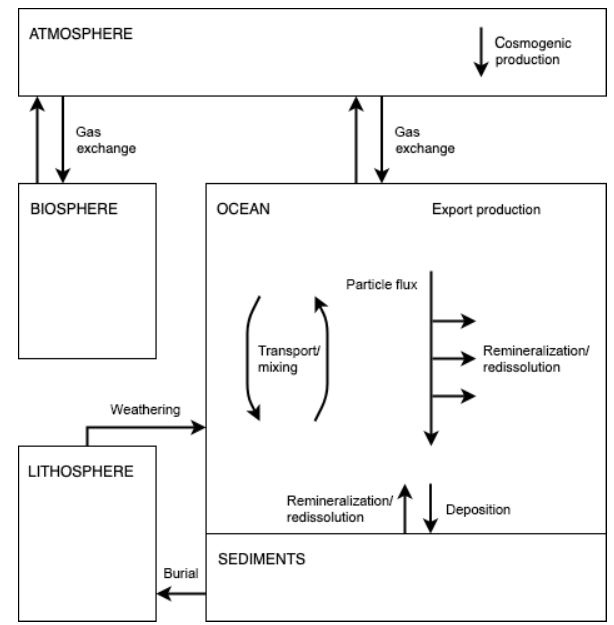
Figure 2. Schematic diagram of the Bern3D carbon cycle model. The fully coupled model includes the major global carbon reservoirs (atmosphere, terrestrial biosphere, ocean, and sediments) and the exchange fluxes between them. Biogeochemical processes, namely air–sea gas exchange, biological export production, and particle flux through the water column, are parameterized by refined OCMIP-2 formulations. Details concerning the model are provided in Sect. 2 and Appendix